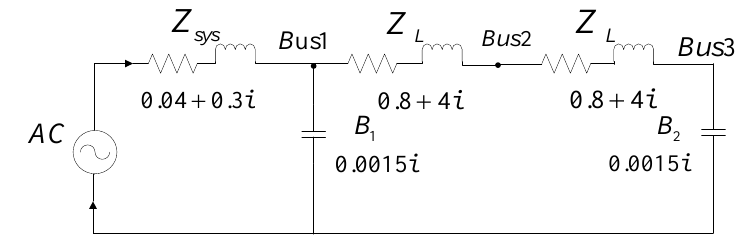
Figure 5. A 3-bus Figure 5. A 3-bus benchmark.